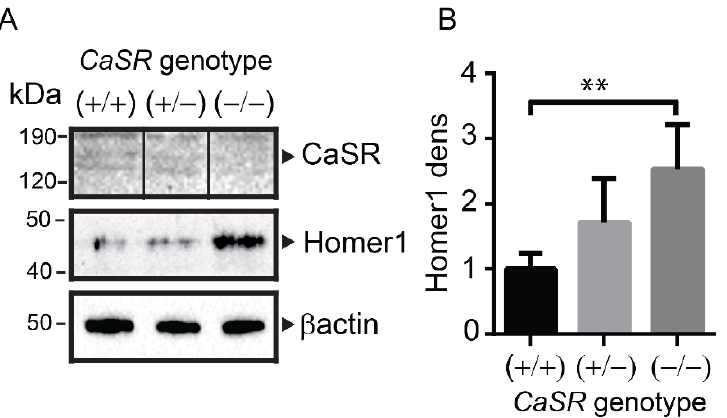
Figure 4. ( A ) Western blot of protein extracted from mouse long bones from wt ( CaSR +/+), heterozygous ( CaSR +/ − ) or CaSR knockout ( CaSR − / − ). β -actin loading control. The faint bands present for CaSR are due to the inefficient extraction of transmembrane associated proteins such as CaSR by non-detergent based chemical extraction of total bone Solid, vertical black lines on the presented Western blotting ( A , CaSR blot) indicate where lanes have been spliced from the same Western blotting for presentation purposes. ( B ) Densitometry of triplicate blots shown in “A” for Homer1 shown as fold of the level in wt ( CaSR +/+). ** p < 0.01.